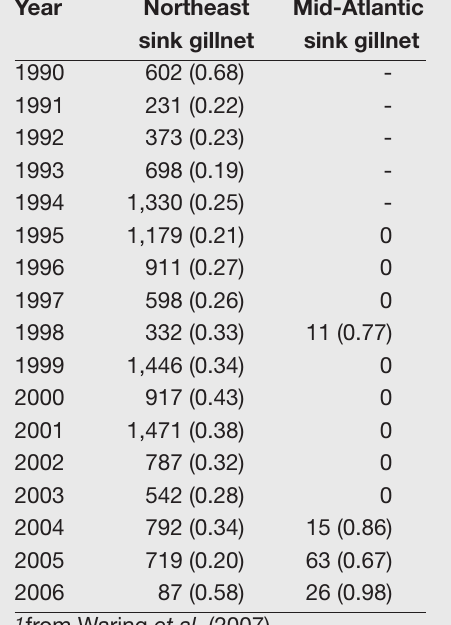
Table 4. Estimated annual harbour seal by-catch in northeast and mid-Atlantic sink gillnet fisheries, with coefficient of variation in parentheses.